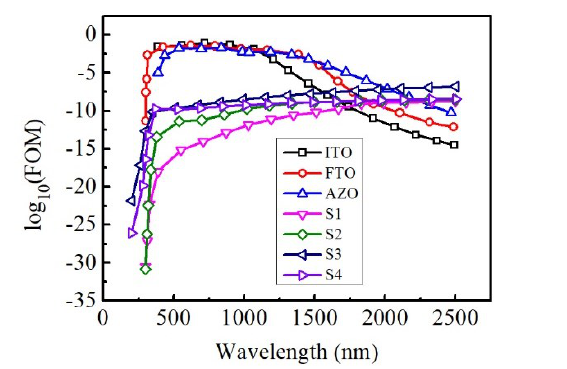
Fig. 5. Spectral dispersion of refractive index (n) and extinction coefficient (  ) from VASE. In the right an inset is added to show the log 10 (  ).